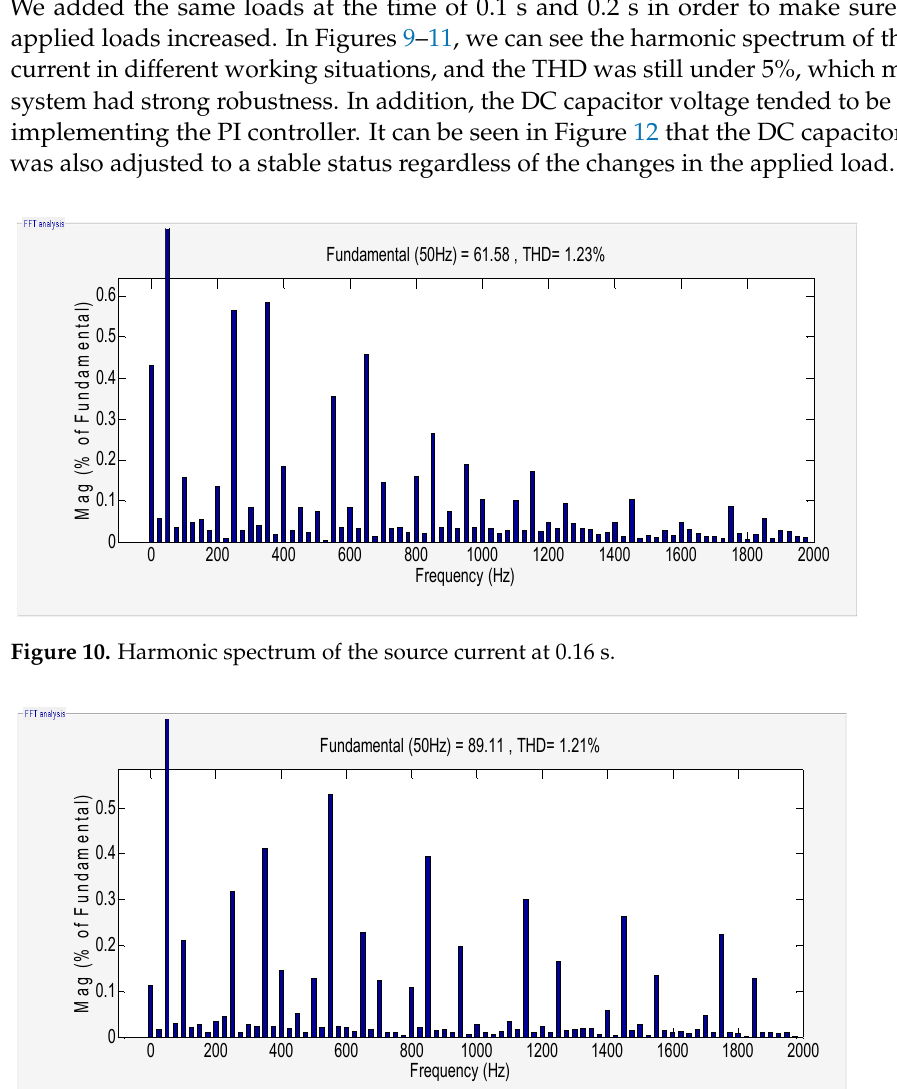
Figure 11. Harmonic spectrum of the source current at 0.26 s.